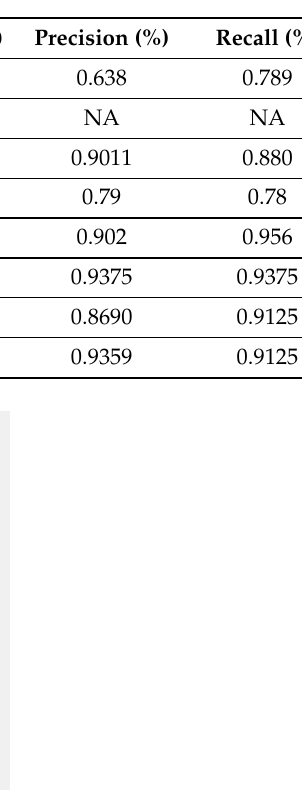
Table 2. Comparison (%) of the results obtained in the PolitiFact dataset using news content and user posting behavior features.